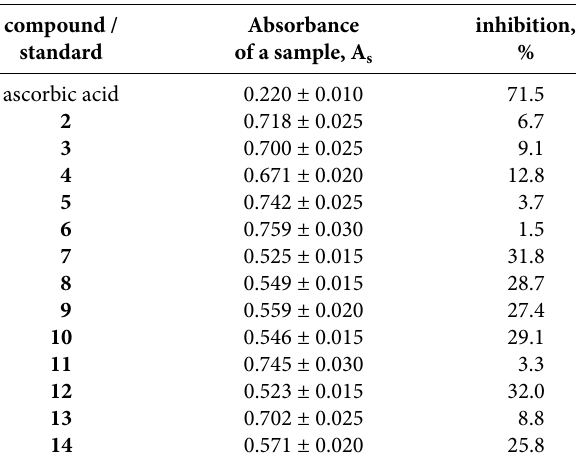
Table 2. Values of Absorbance and % of inhibition of thiazolo[4,5- b ] pyridine-2-ones. compound / Absorbance inhibition, standard of a sample, A s % ascorbic